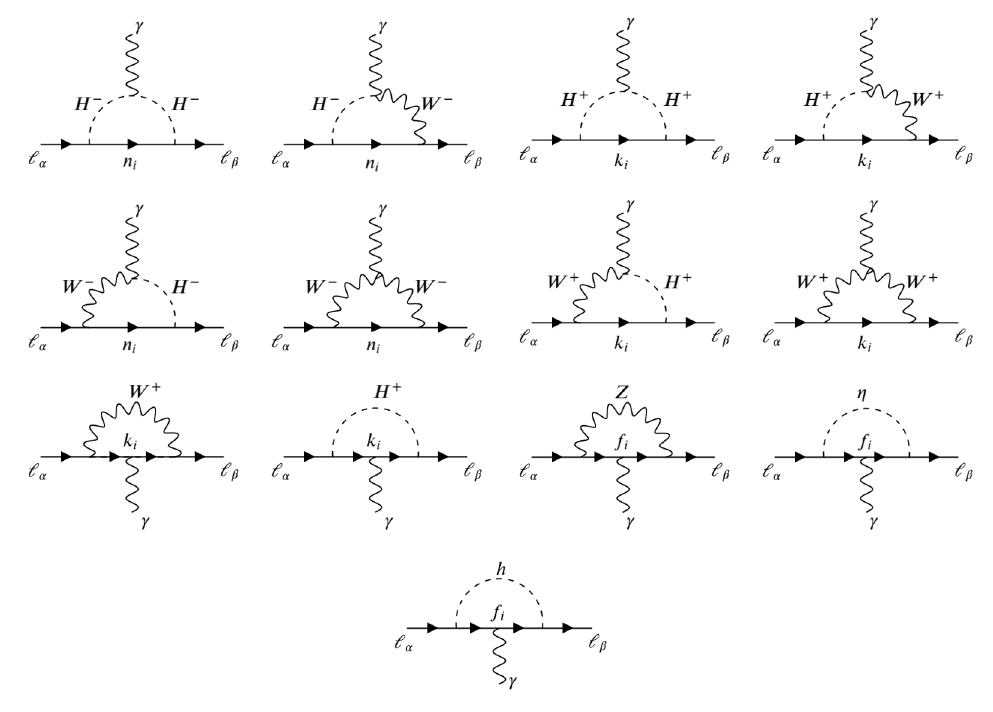
Figure 2 . Vertex-type diagrams. n i , f i and k i symbollically stand for any of the neutral, singly- charged and doubly-charged fermions, respectively.